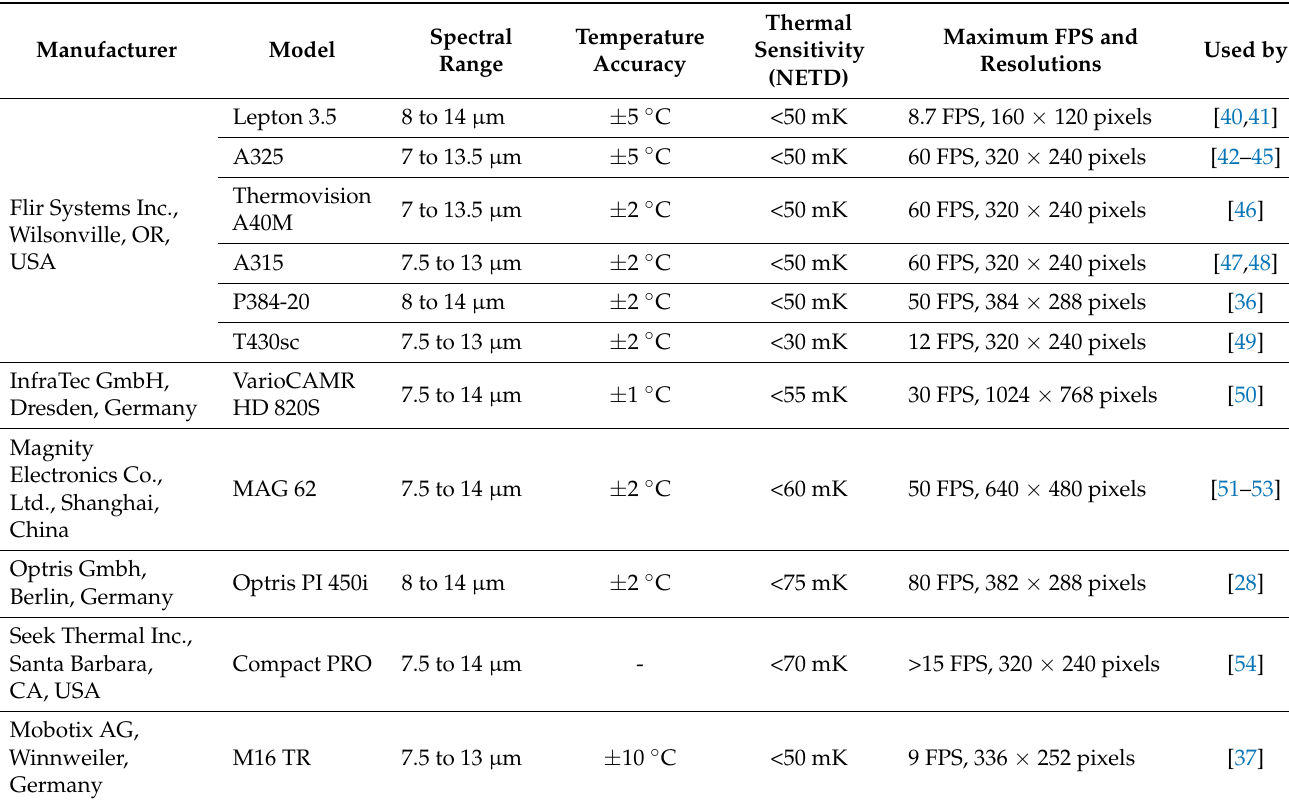
Table 2. List of Thermal Cameras Used in Some Studies in this Systematic Review Along with The Specifications